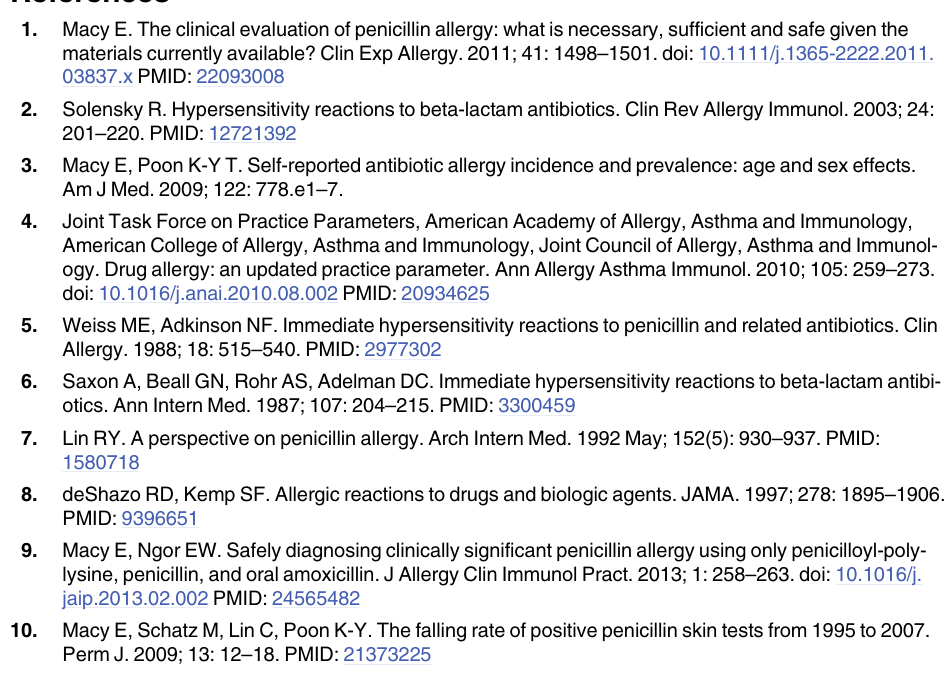
S1 Table. Among patients who received an antibiotic, first antibiotic prescribed after anti- biotic allergy documentation by age group 1,2 . (cid:1) p < 0.001. 1 Rows do not add up to 100 because other antibiotic classes not displayed. 2 Only patients who received an antibiotic after allergy documentation were included. For patients who did not have a beta-lactam allergy doc- umented, the first antibiotic prescribed is the first antibiotic received during the study period. S2 Table. Among unique patients with characteristics of beta-lactam allergy documenta- tion, the first antibiotic received at the first inpatient or outpatient clinical encounter with a diagnosis of cellulitis (by ICD9 code) 1,2 . (cid:1) p < 0.001; ǂ p < 0.01. 1 Rows do not add up to 100 because other antibiotic classes not displayed. 2 For patients with a beta-lactam allergy, first antibiotic received was after allergy